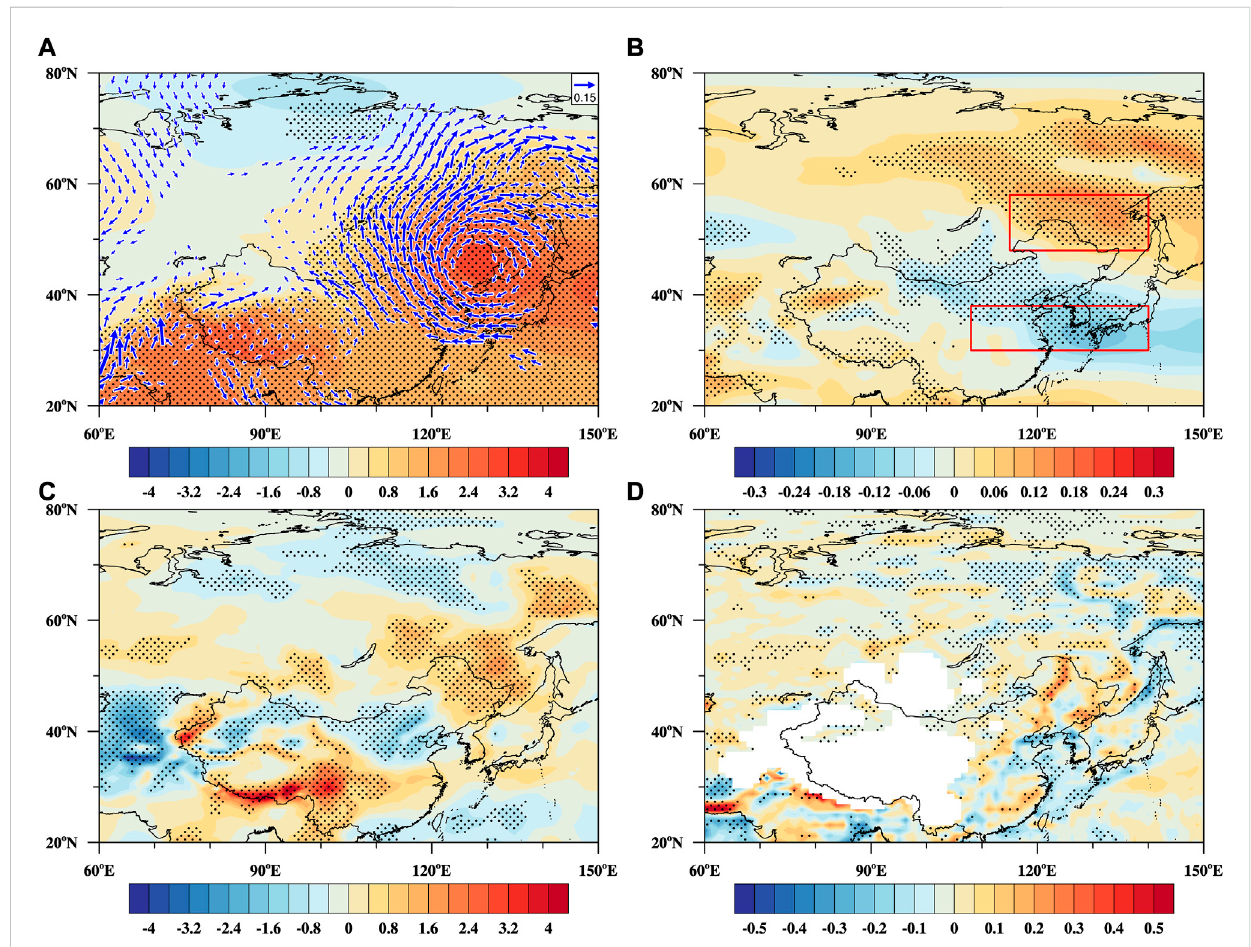
FIGURE 6 Regressions of summer anomalous (A) 850 hPa geopotential height (shading; unit: m) and horizontal wind (vector; unit: m s − 1 ), (B) 850 hPa zonal wind (unit: m s − 1 ), (C) 500 hPa vertical velocity (unit: 10 – 3 Pa s − 1 ), and (D) moisture divergence vertically integrated from the surface to 850 hPa (unit: 10 – 5 kg m − 2 s − 1 ),againstthenormalizedCDDAindexintheCESM-LEMMEduring1960 − 2019.Stippledregionsandvectorsindicatethattheanomaliesare signi fi cant at the 95% con fi dence level. The red boxes in (B) indicate the regions used to de fi ne the